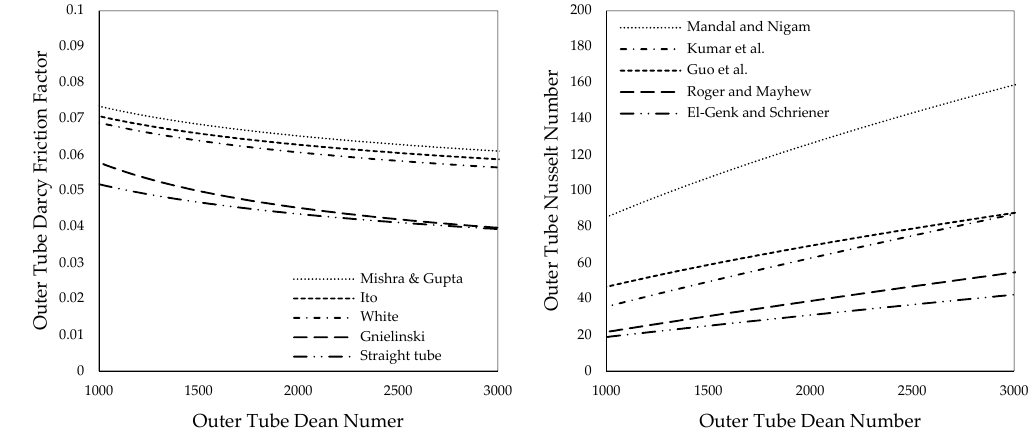
Figure 5. Friction factor ( left ) and Nusselt number ( right ) over Dean numbers of the outer tube for solar salt.